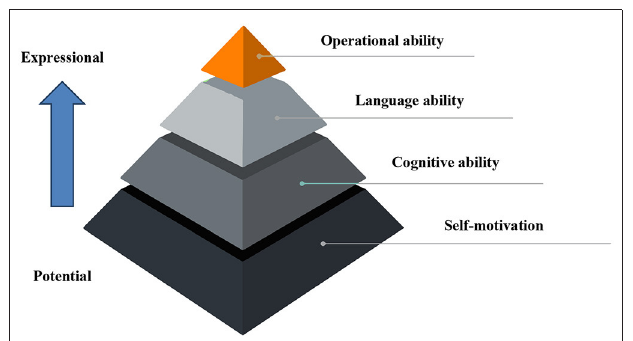
FIGURE 2 | English communication ability